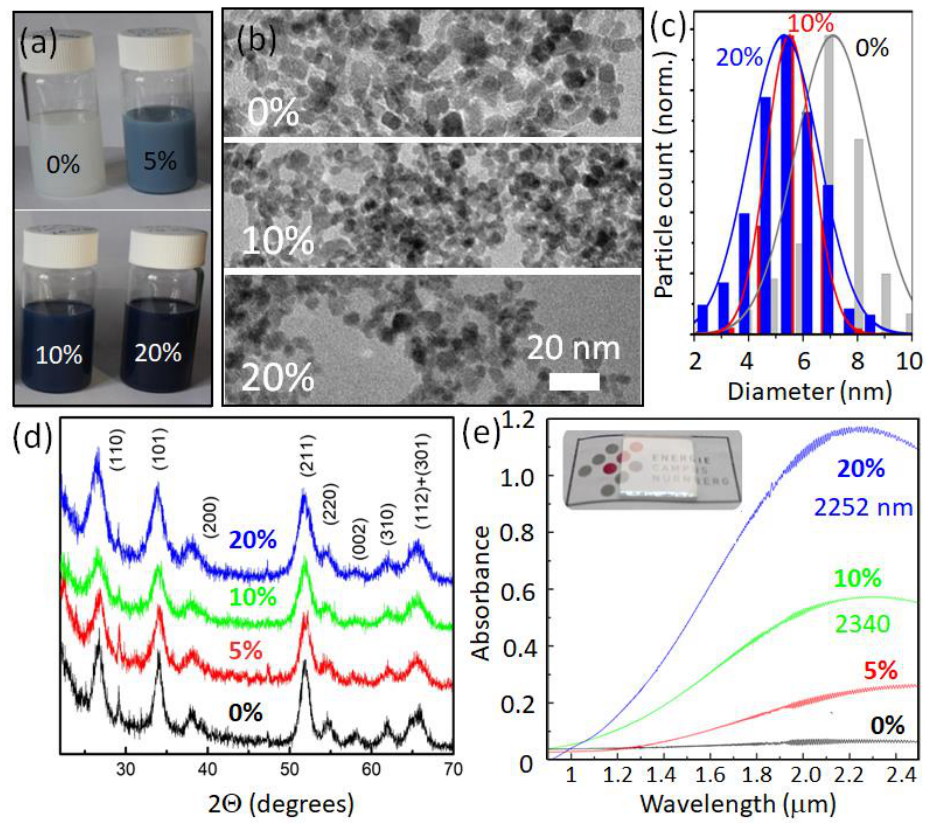
Figure 1. Synthesized ATO nanocrystals. ( a ) Photo of the colloidal solutions of OA capped NCs for various doping concentrations given in atomic per cents (100 mg/mL in toluene). ( b ) TEM images, ( c ) size distribution histograms, ( d ) XRD patterns of ATO NCs with various nominal Sb concentrations, and ( e ) infrared absorbance of ATO NC films (a typical film on a glass substrate is shown in the inset). Next to the nominal doping concentrations, the LSPR resonance wavelengths are provided for the 20% and 10% curves.